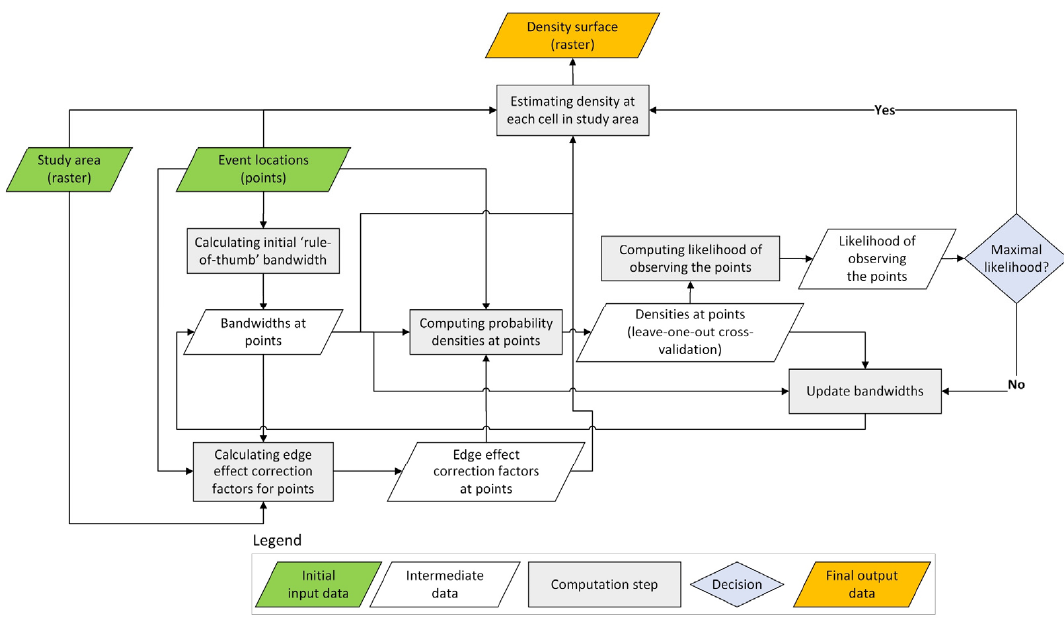
Figure 2. Computation steps in the existing GPU-parallel KDE algorithm.